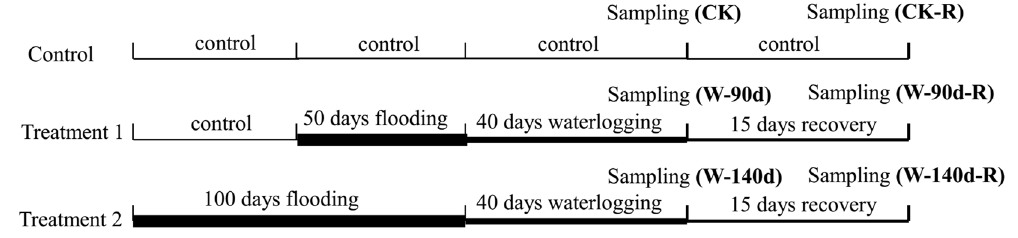
Figure 8. Illustration of the experimental